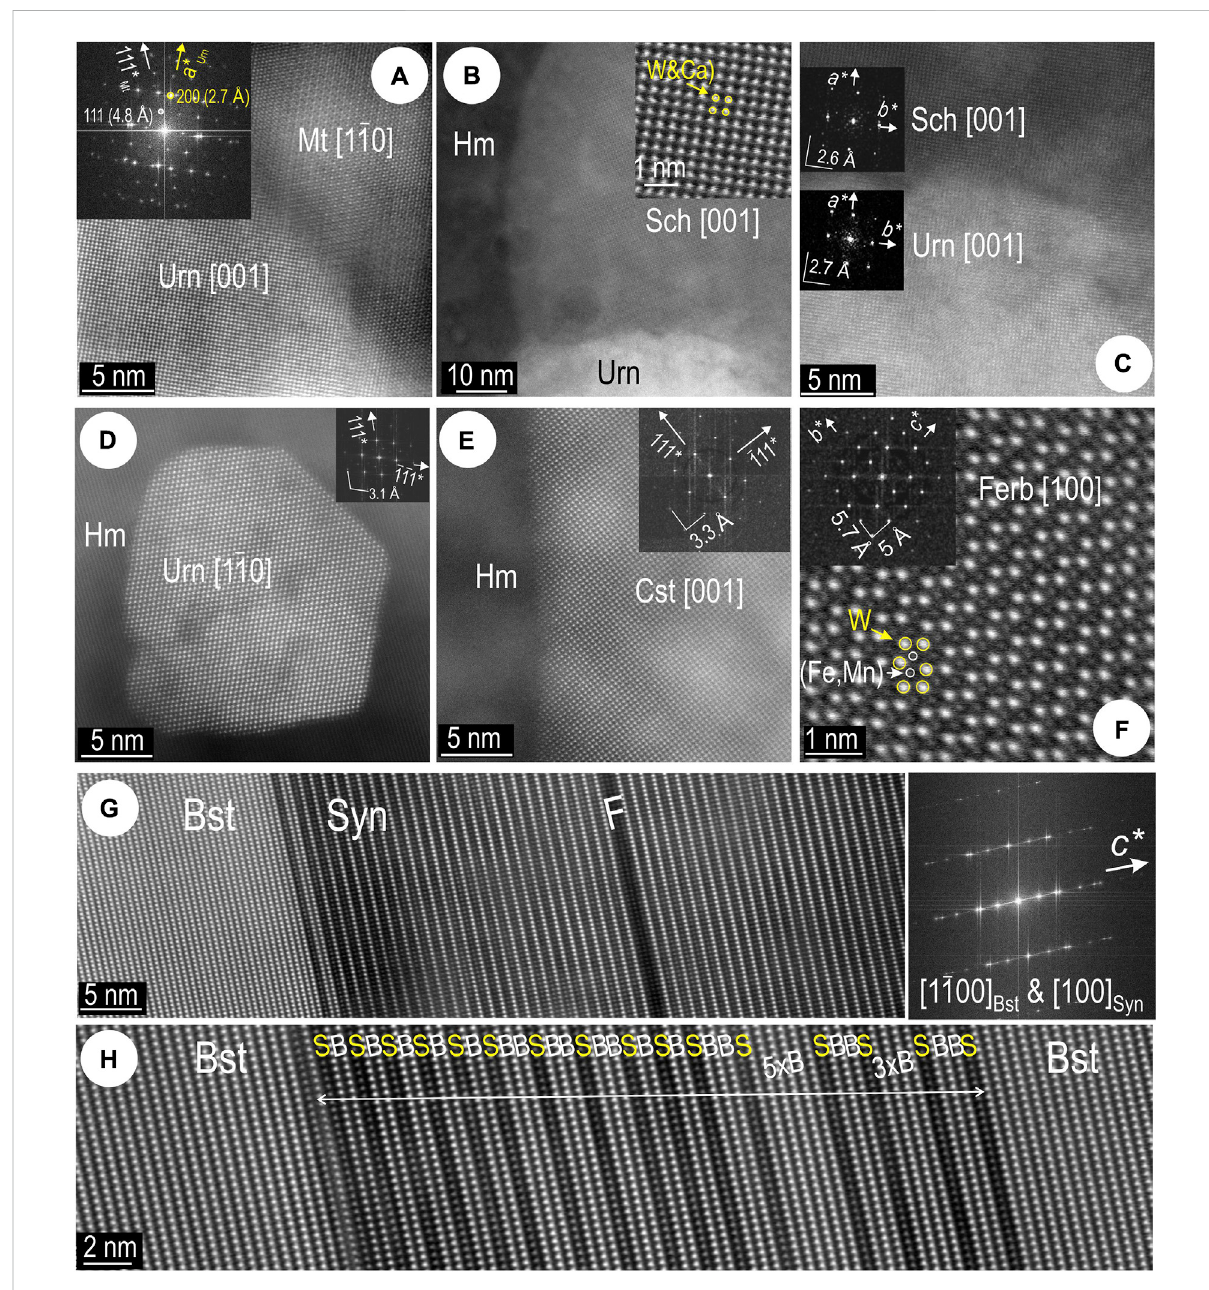
FIGURE 8 High- and atomic-scale resolutionimagesshowing crystal-structural aspectsof nanoinclusions in hematite from (foils Hm#1 – 3) (A – F) and the BSG lamella in silician magnetite(FoilMt#2) (G,H) in sample CLC21.Zone axes as marked in square brackets, and orientation on FFT patterns (insets) (A) Congruent boundary between uraninite (Urn) and host magnetite (Mt). (B) Scheelite (Sch; detail as inset) and uraninite in hematite (Hm). (C) Congruent boundary between scheelite and uraninite both on [001] zone axis. (D) Uraninite NP attached on a pore in hematite, zone axis as marked. (E) Boundary domain between cassiterite (Cst) NP and host hematite. Note lack of congruency with host hematite. (F) Ferberite on [100] zone axis, with W and (Fe,Mn) sites identi fi ed (overlay). (G) Boundary between bastnäsite (Bst) and synchysite (Syn). Note disordering in synchysite close to the boundary. F ─ crystal fault. FFT pattern (right) shows strong disorder on c* axis with overlap between zones axes of the two minerals as marked. (H) Detail of disordered bastnäsite domain with various stacking modules as marked. “ B ” and “ S ” refer to bastnäsite and synchysite modules,